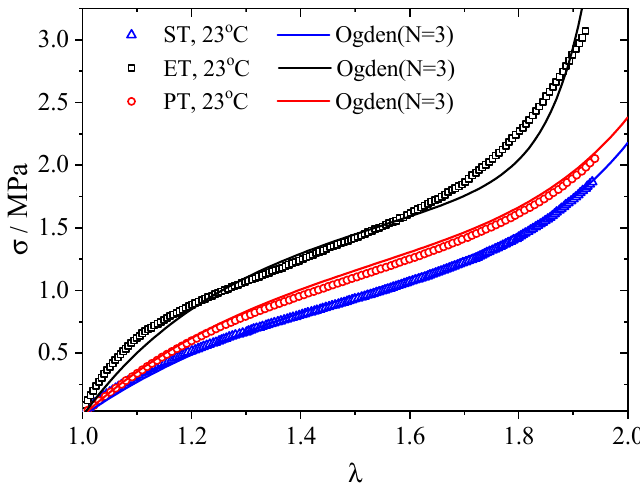
Figure 3. Stress–stretch curves for simple tension (ST), planar tension (PT) and equal-biaxial tension (ET) tests of rubber and their Ogden model fits.